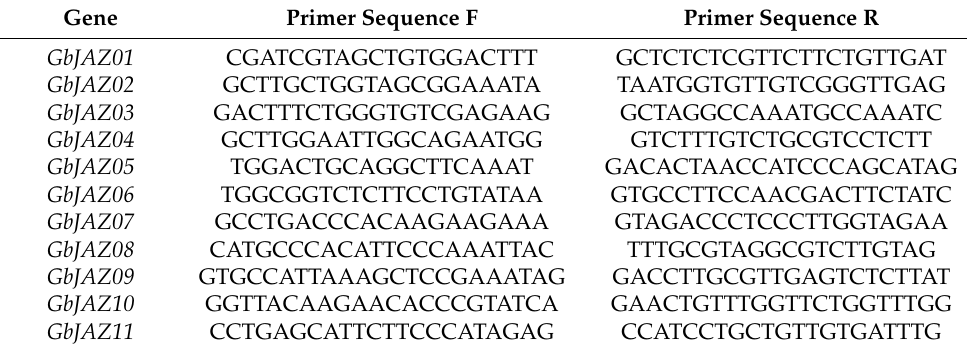
Table 1. qRT-PCR primer sequence of GbJAZs. Gene Primer Sequence F Primer Sequence